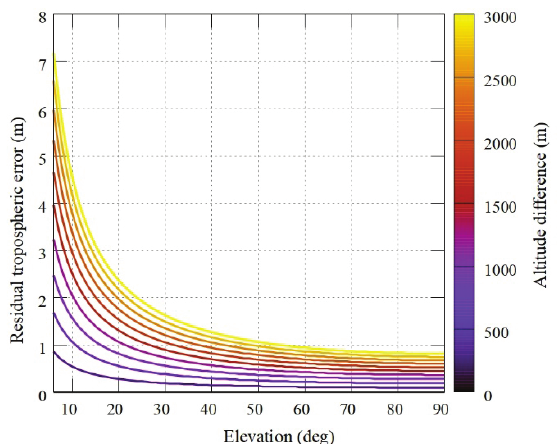
Figure 8. The dependence of residual tropospheric error on the navigation satellite elevation angle and altitude difference between airborne and ground subsystems